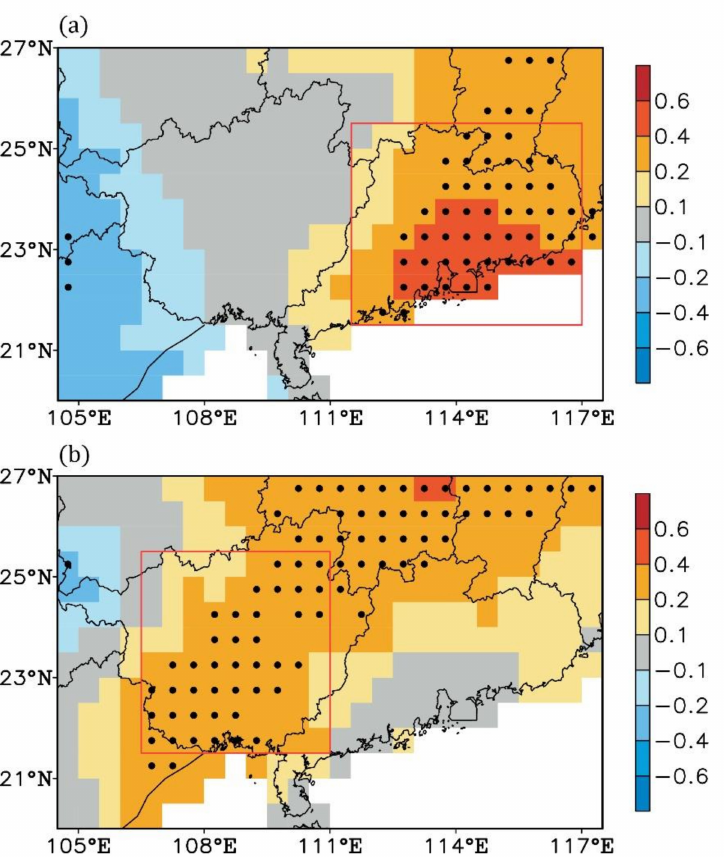
Figure 7. Correlation coefficients between the spring precipitation anomalies and the preceding winter ONI for the years with ( a ) ONI > 0 and ( b ) ONI < 0. The dotted areas are significant with p < 0.1. All data are linearly detrended. The red boxes in ( a ) and ( b ) denote the Guangdong province and Guangxi province regions,